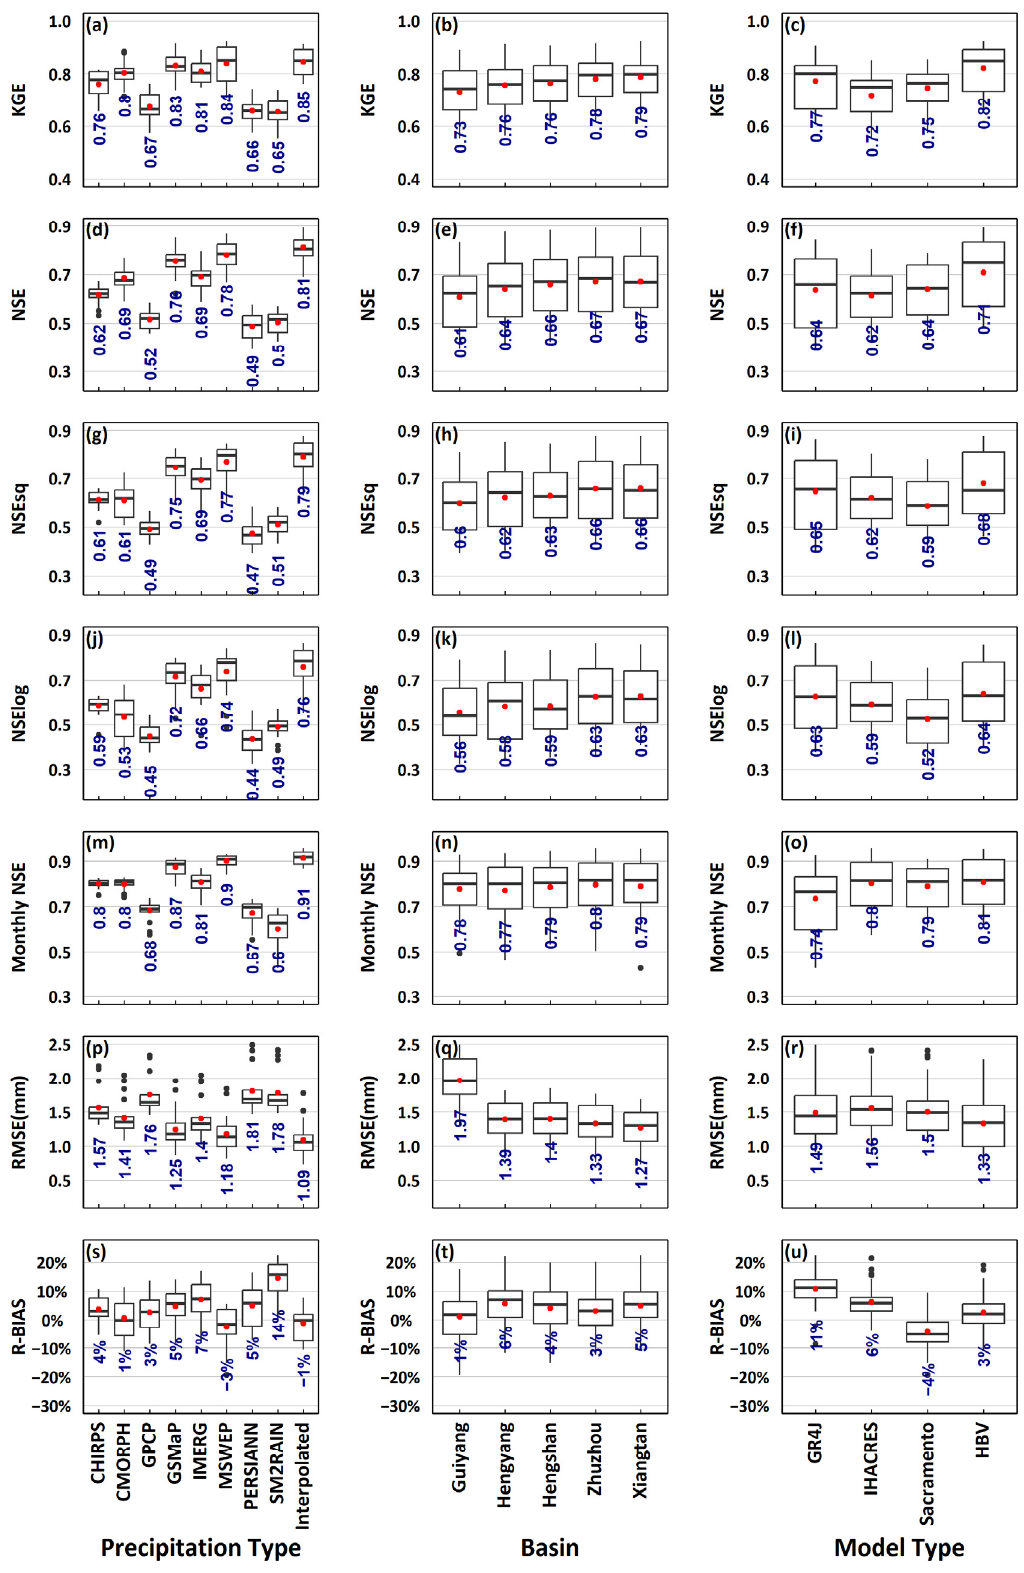
Figure 7. Boxplot of performance indicators ( a – c ) KGE, ( d – f ) NSE, ( g – i ) NSEsq, ( j – l ) NSElog, ( m – o ) Monthly NSE, ( p – r ) RMSE, ( s – u ) R-BIAS for hydrologic modelling driven by various precipitation inputs at five sub-basins in XJRB. The red dot represents the corresponding statistics’ average value (labelled in blue), and the black dots represent outliers.